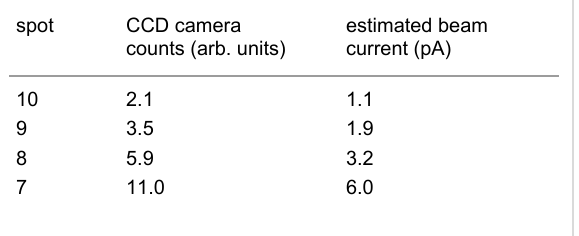
Table 1: The counts on the CCD camera and the estimated beam current as a function of spot size. spot CCD camera counts (arb.